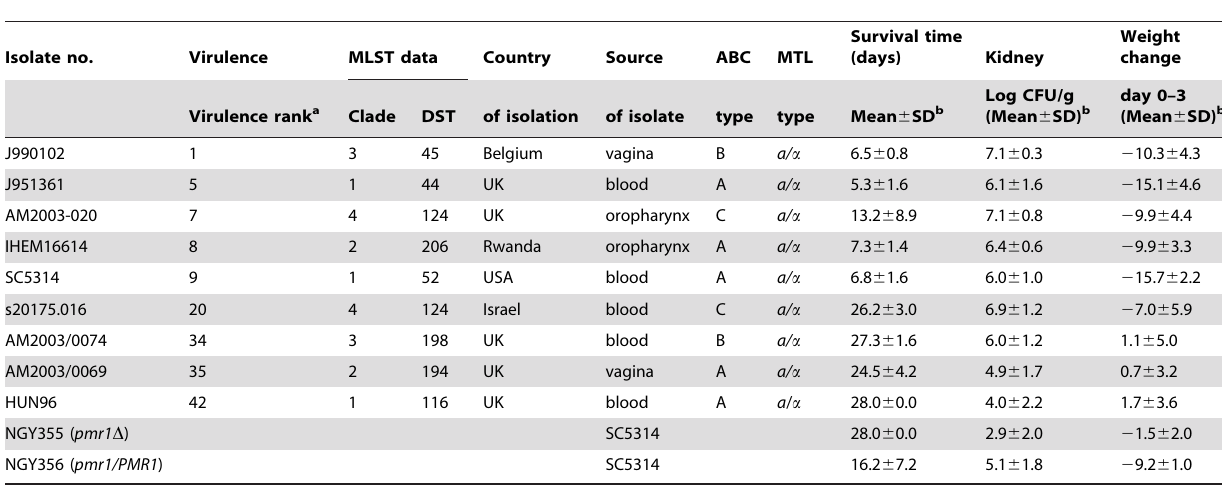
Table 1. Details of the 11 C. albicans strains used in this study.